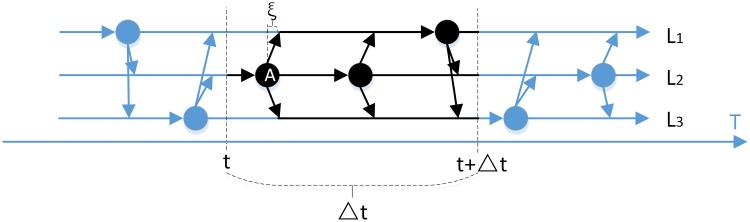
Status transition sample by CTS-MM.